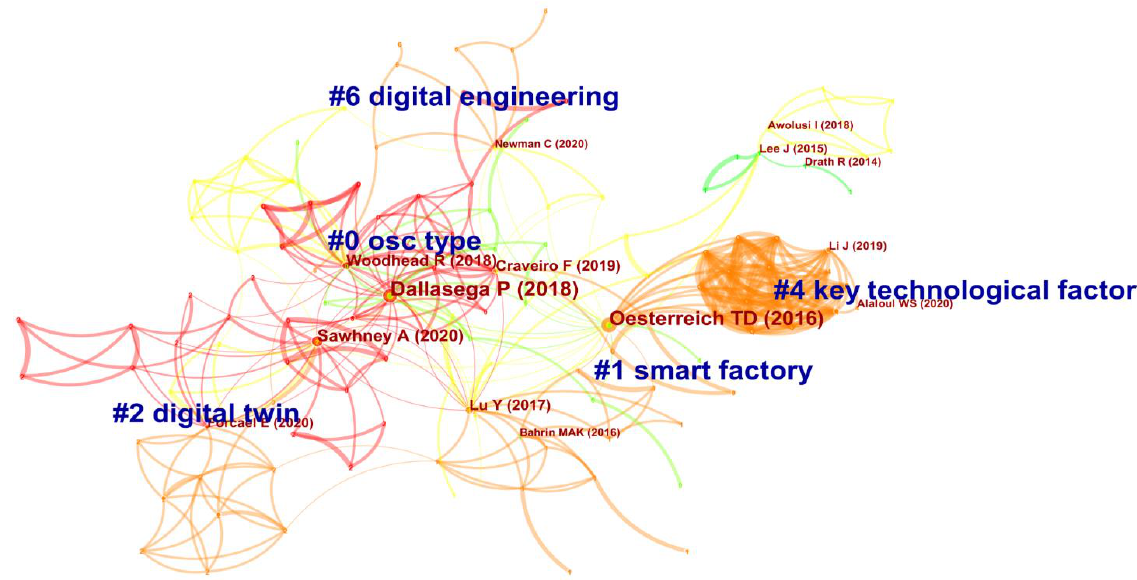
Figure 17. Abstract clustering network map of co-citations for Industry 4.0 in construction. Table 9. Co-citation clusters of Industry 4.0 in construction from 2006 to 2022.